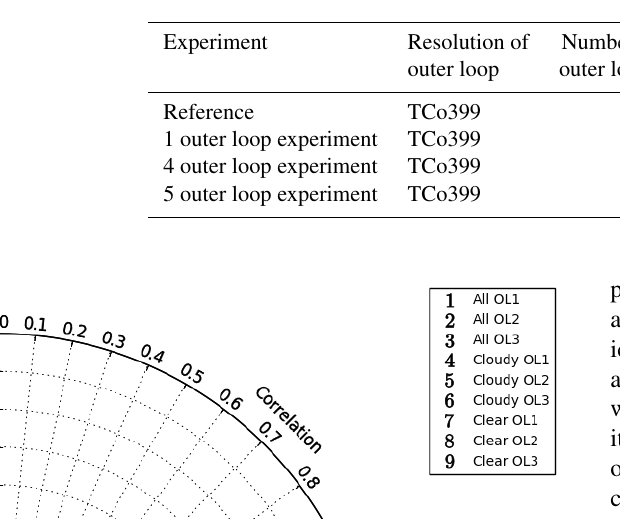
Table 1. Resolution and number of outer loop iterations for the sensitivity experiments discussed in Sect. 5. TCo399 means IFS model integrations with spectral triangular truncation 399 and a cubic octahedral reduced Gaussian grid. TLXXX mean IFS model integrations carried out at spectral triangular truncation XXX on a linear reduced Gaussian grid. All minimisations are performed using the full physics tangent linear and adjoint models.